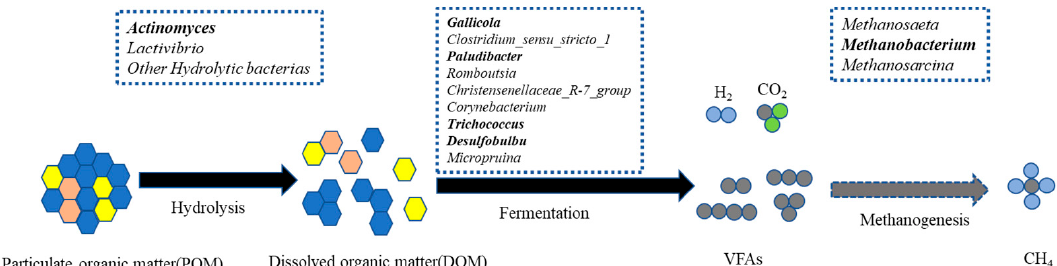
Figure 10. Proposed pathway of carbon source release from POM via intermittent microaeration.